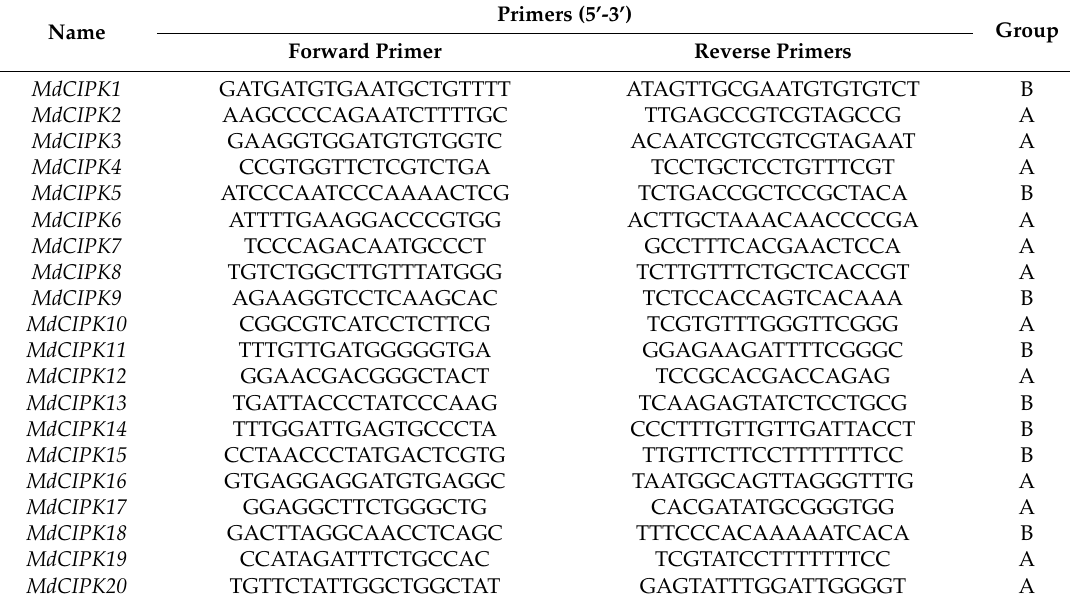
Table A1, Information of primers for qPCR. Table A1. Information of primers for